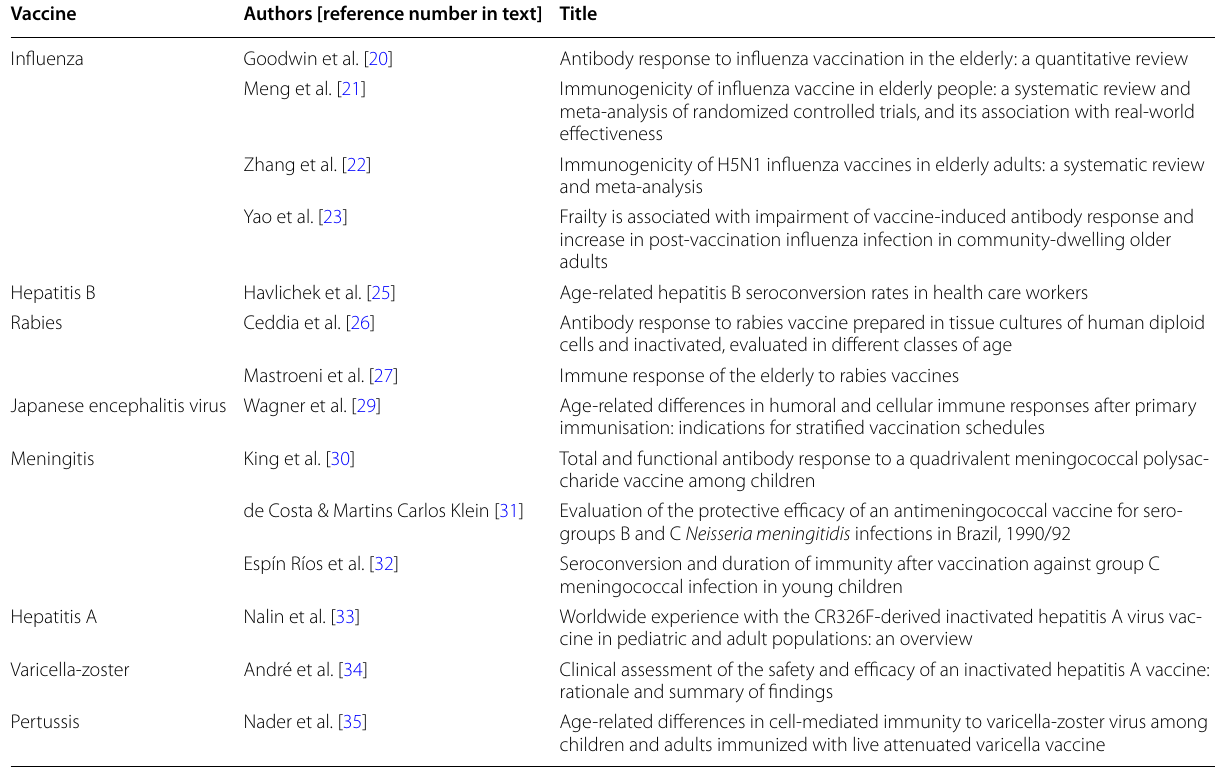
Table 2 Vaccine examples showing decreased seroconversion in the elderly